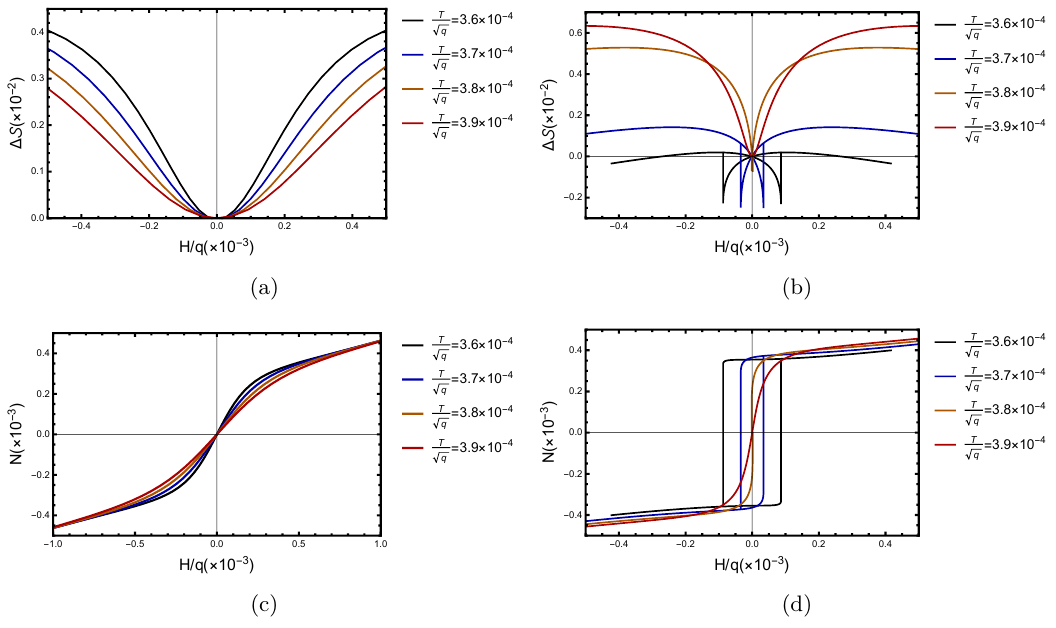
Figure 5 . (a) and (c) corresponds to blue dots in figure 1 while (b) and (d) corresponds to red dots in figure 1. These are our novel predictions which can be checked by